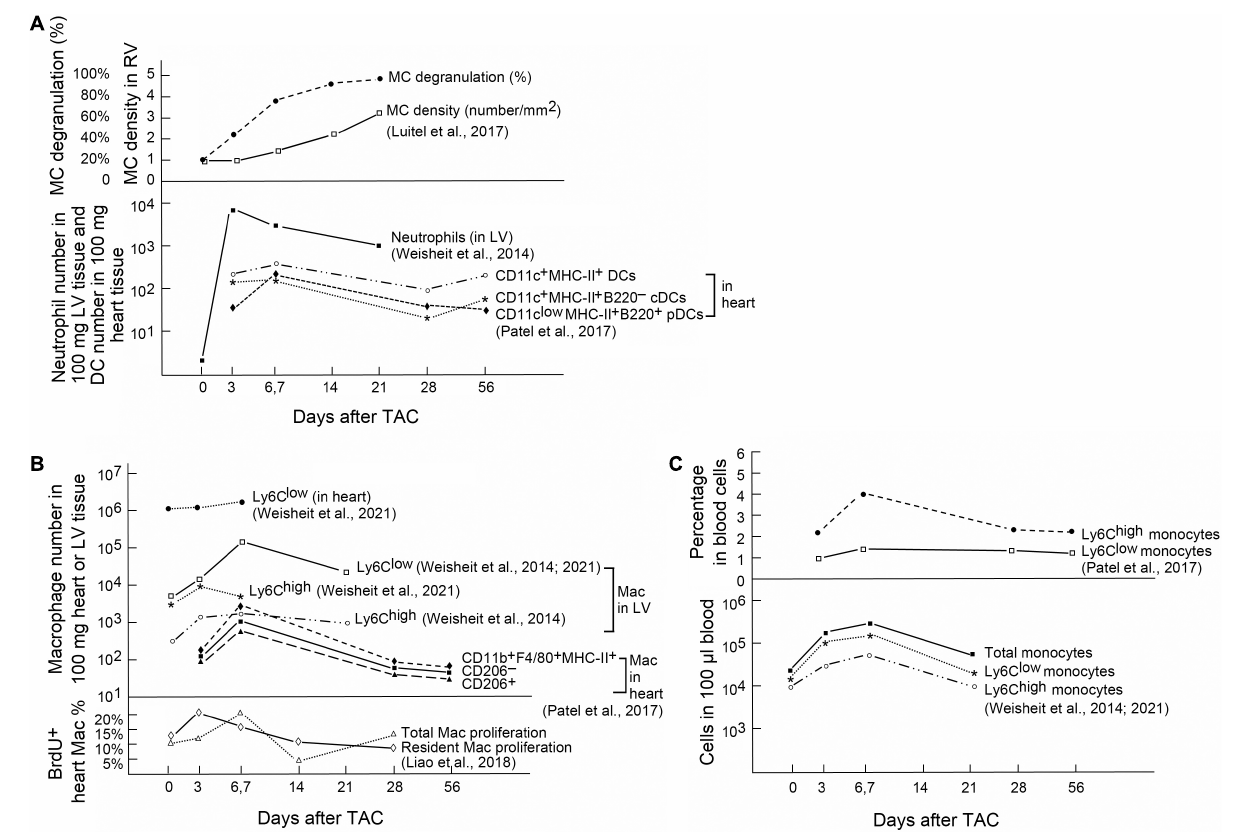
FIGURE 1 | Innate immune cells in heart and blood from mice after pressure overload-induced cardiac hypertrophy. (A) Upper: Toluidine blue staining detected MC density and percentage of degranulated MCs in RV from mice with PAC-induced pressure overload. Bottom: FACS determined the absolute number of neutrophils and different DCs in 100 mg heart or LV tissues from mice after TAC-induced pressure overload. (B) Upper: FACS analysis of different macrophage subsets in 100 mg heart or LV tissues from mice with TAC-induced pressure overload. Bottom: BrdU staining followed by FACS analysis to detect proliferation of heart-resident and total macrophages in TAC-treated mice. (C) Upper: Percentage of different monocyte subsets in total blood cells from TAC-treated mice. Bottom: Absolute numbers of different monocyte subsets in 100 µ l of blood from TAC-treated mice. Graphs were generated by grouping the results from different studies. References are